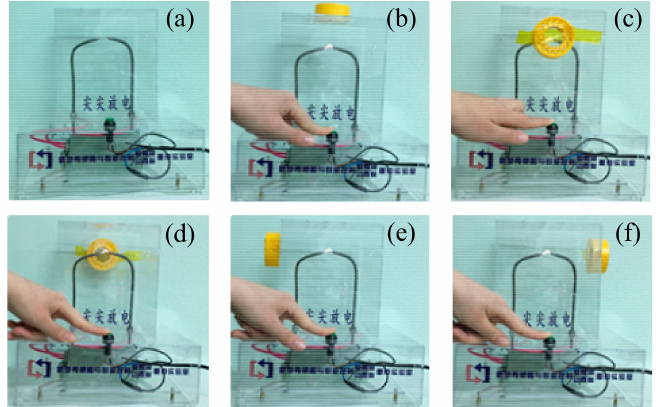
Figure 9. Detection experiments using the optical fiber sensing probe in different positions. ( a ) No PD event. The sensing probe is placed ( b ) on the top, ( c ) in the front, ( d ) behind, ( e ) on the left side and ( f ) on the right side of the discharge protection